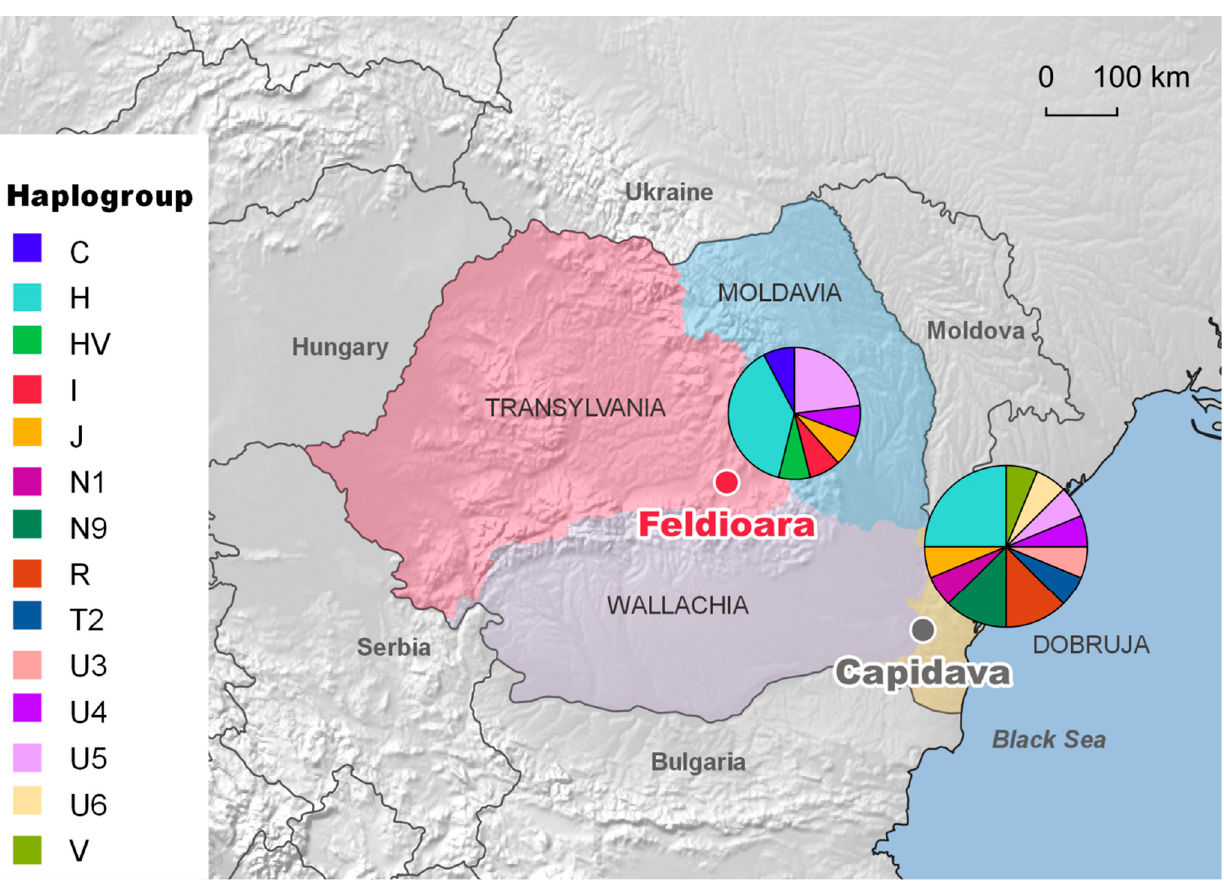
Figure 1. Geographic and genetic relationships between two medieval populations from the current territory of Romania: the population from Feldioara (labeled in red), located in the historical region of Transylvania, was investigated in this study, while the population from Capidava (labeled in grey, and labeled as seROU_med in further graphs and text), located in the province of Dobruja, was analyzed in previous studies [20,42]. Pie charts represent the frequencies of the major haplogroups in these populations. The size of the charts is proportional to the number of samples from each necropolis.